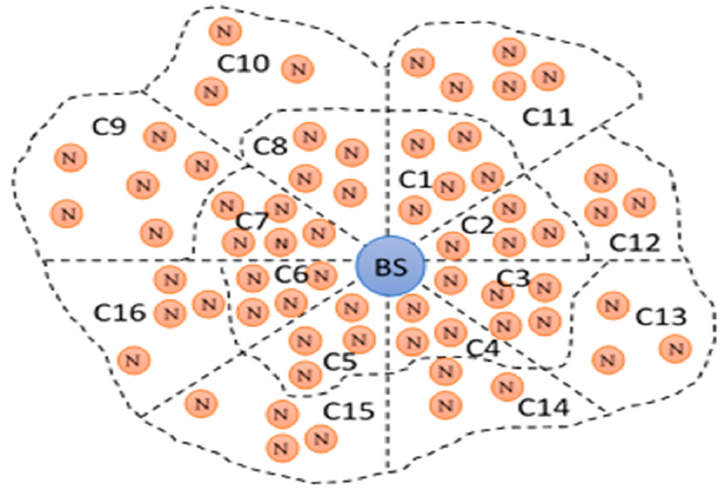
Figure 1. Network divided into 16 clusters.